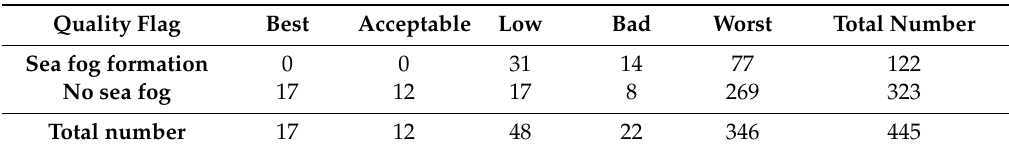
Table 6. Comparison of the L3 SST data flags (best, acceptable, low, bad, and worst) and sea fog appearances detected by the MTSAT at the locations of ocean buoys D and O for June and July from 2010 to